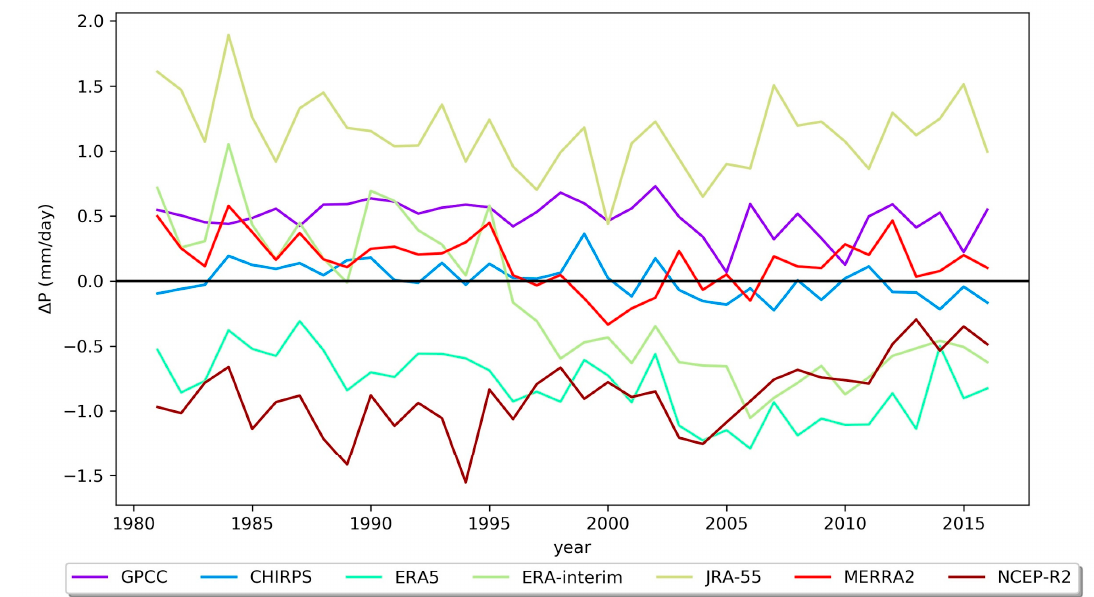
Figure 8. Time evolution of regional mean JJAS rainfall difference between CRU and other observational and reanalysis datasets averaged over West Africa.